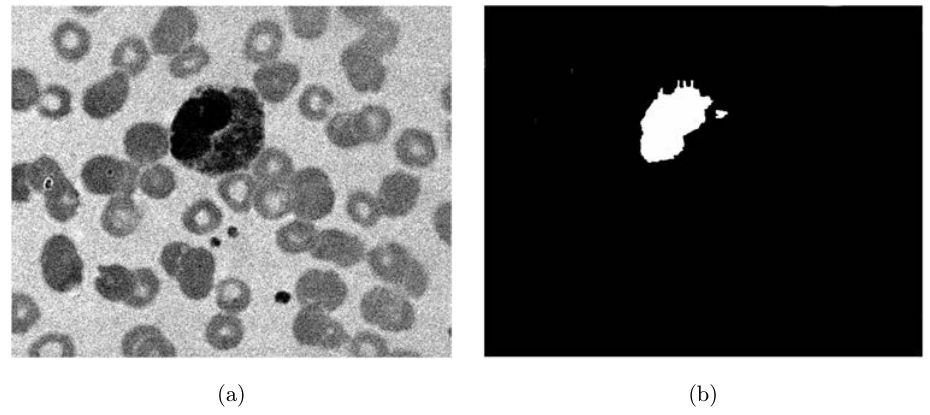
Fig. 4. (a) The 1st band hyperspectral image of eosinophil. (b) Result after segmentation.